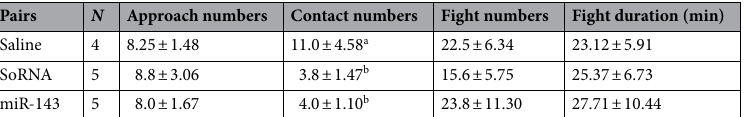
Table 1. The numbers of approach, contact and fight in the groups of crustacean saline (saline), SoRNA, miR- 143 injection. The different lowercase letters indicate a significant difference between the saline other injection groups ( P < 0.05). The different lowercase letters indicate that there is a significant difference in the numbers of contact between saline and other injection groups ( P < 0.05).